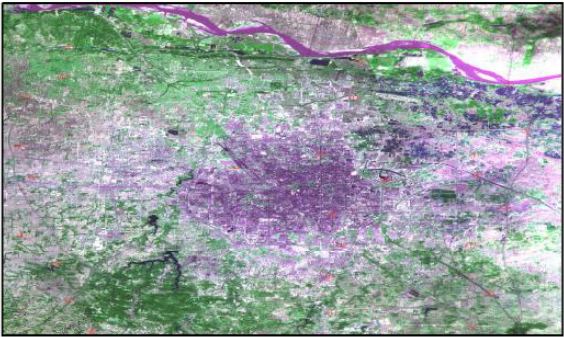
Fig. 1. Standardized sharpening